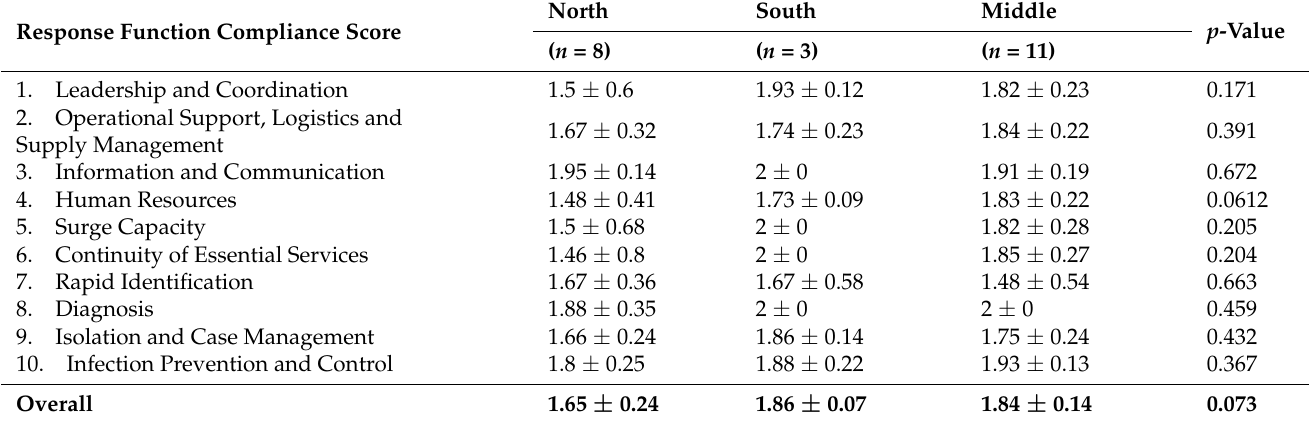
Table 3. Average compliance score of participating hospitals according to response function stratified according to hospital